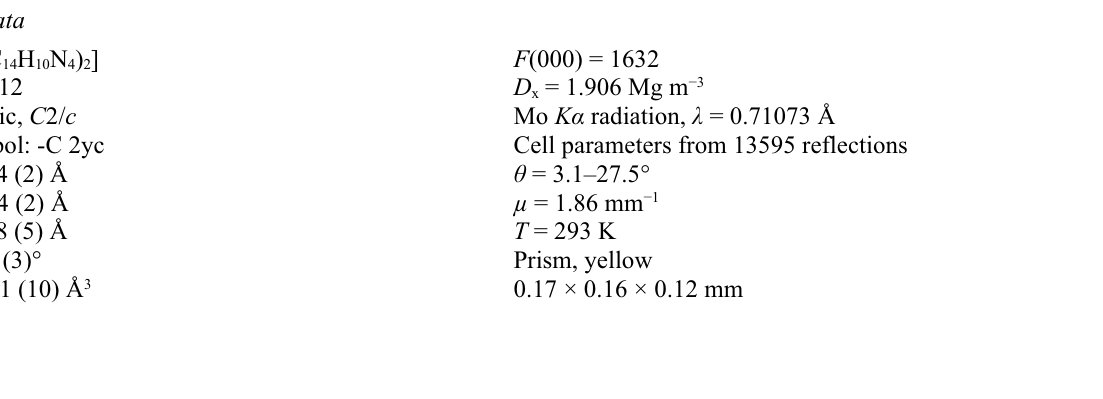
sup-2 Acta Cryst. (2009). E 65 , m37